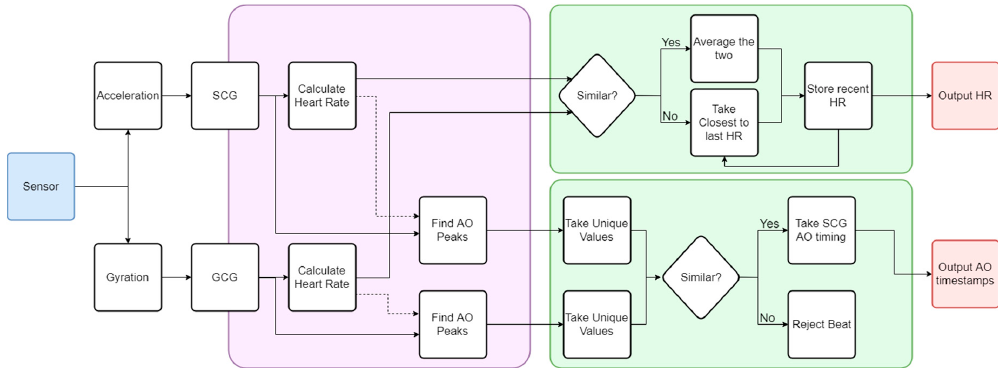
Figure 3. Flowchart of the autocorrelated differential algorithm (ADA) algorithm extended to include GCG, thereby enabling complete vibrational cardiography (VCG) measurements. The violet region incorporates the core ADA algorithm computed for both SCG and GCG. The green region contains the decision protocol. Key output parameters are in red.